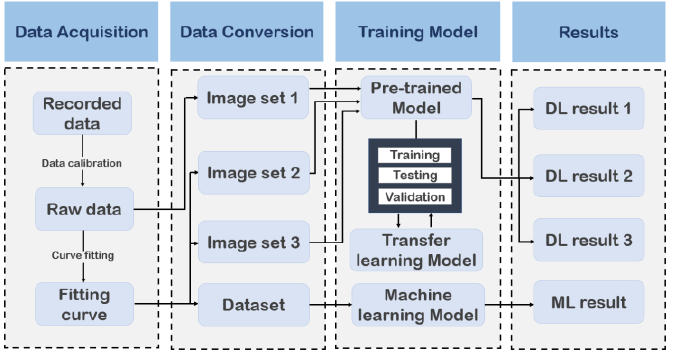
Figure 3. General technical route.